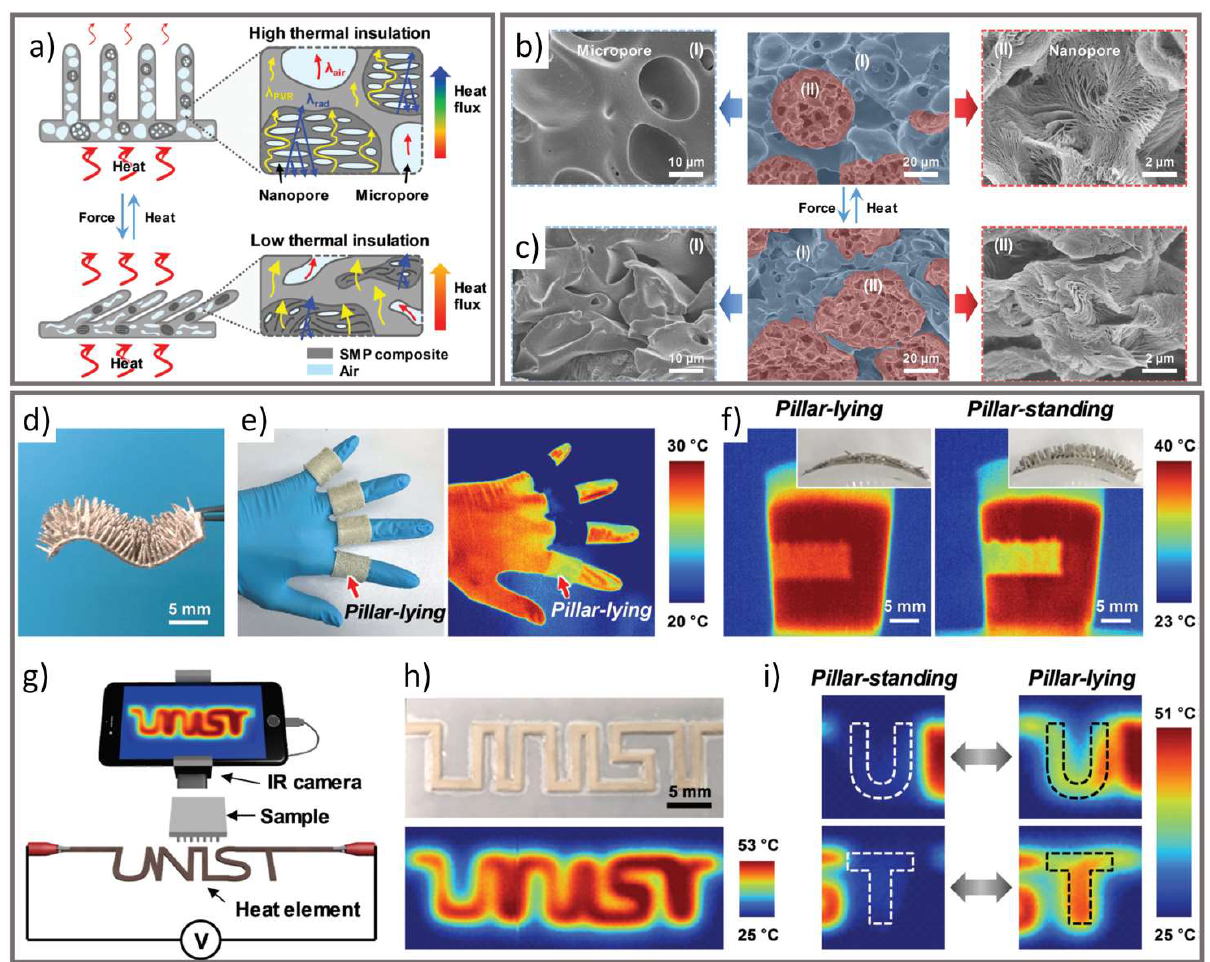
Figure 6. ( a ) Schematic illustration of hairy SMP structure before and after deformation and its effect on the thermal insulation property. ( b , c ) Cross-sectional scanning electron microscope (SEM) images of micropores and nanopores of original and deformed SMP membrane. ( d – f ) The effect of SMP hair standing (pillar-standing) and deformed (pillar-lying) structures on thermal insulation property. ( g – i ) IR images of thermal encrypted texts and other letters (republished from [50] with permission of Royal Society of Chemistry; permission conveyed through Copyright Clearance Center, Inc.).